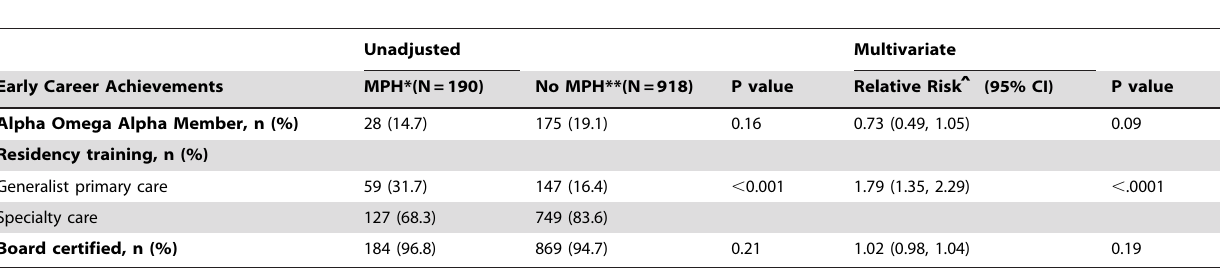
Table 2. Unadjusted and Multivariate-Adjusted Analyses of Early Career Activities Associated with MPH Education Completion among Medical School